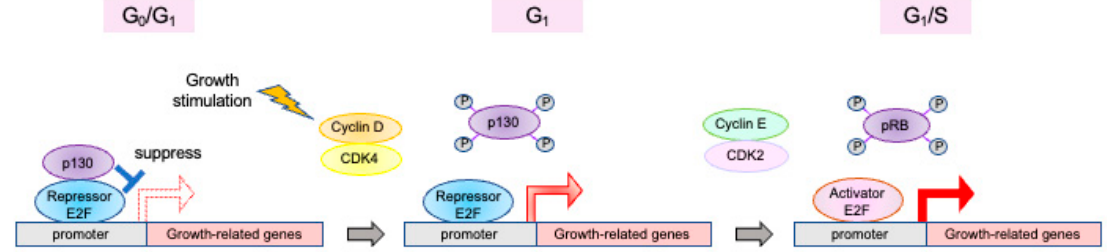
Figure 3. Mechanism of cell cycle progression mediated by E2F. In the resting state, the DREAM complex, including repressor E2Fs and p130, actively suppresses E2F target gene expression. Upon growth stimulation, the expression of cyclin D is induced, activating CDK4/6, which phosphorylates p130 and relieves repression by the DREAM complex. Repressor E2Fs, freed from repression by the DREAM complex, now induces the expression of growth-related genes such as cyclin E and activator E2Fs, further inactivating pRB and activating E2F. This feedback loop shifts RB inactivation and E2F activation from the growth-dependent D-type CDK to the E2F-dependent E-type CDK, thereby facilitating transit through the restriction point. After the restriction point, progression of the cell cycle proceeds autonomously to the end of mitosis.